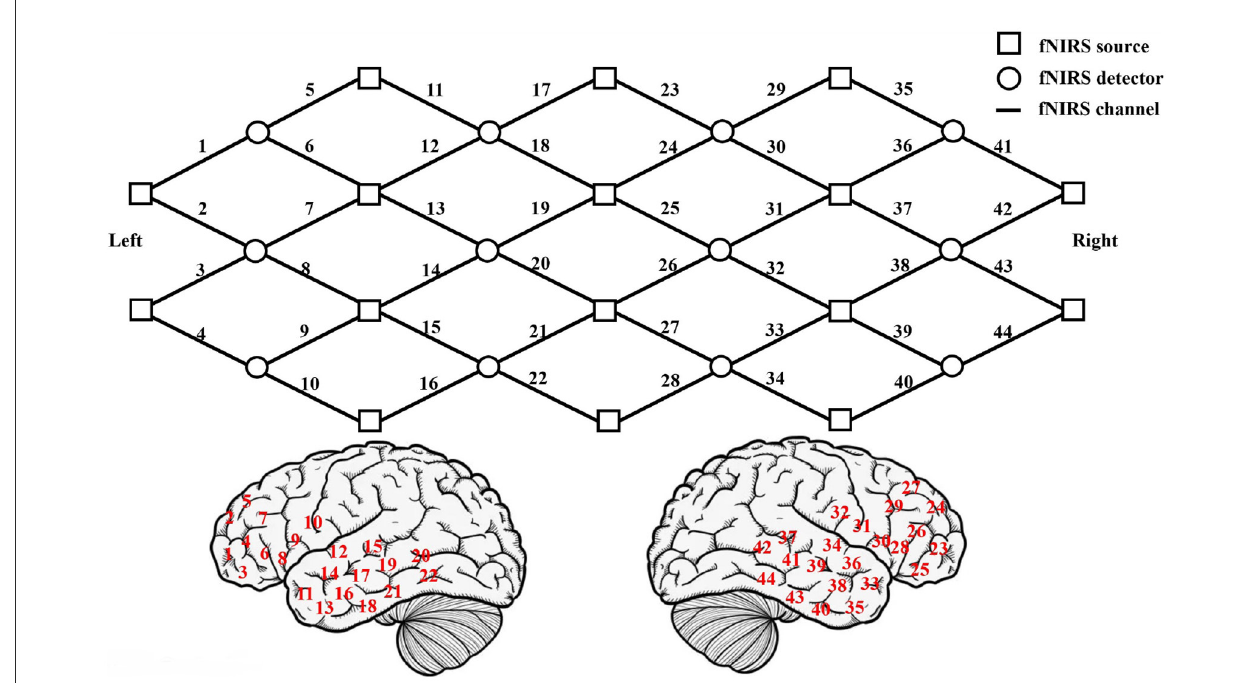
FIGURE1 The upper picture shows the location of fNIRS measurement channels. The lower picture shows the location of each channel on the cerebral cortex.